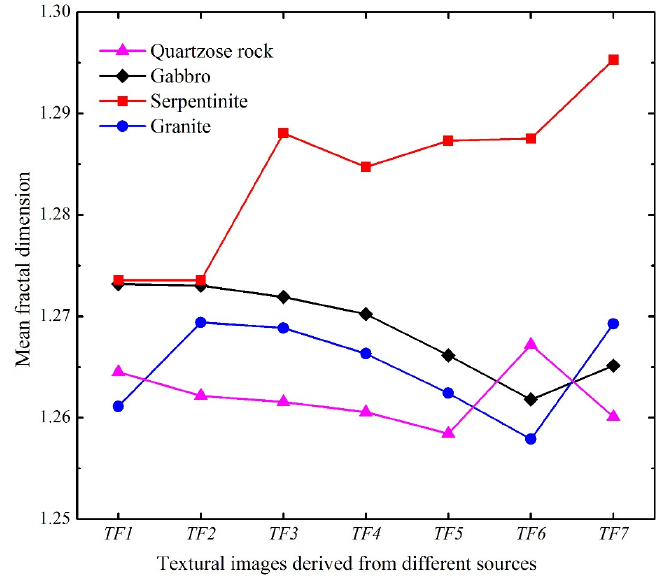
Figure 4. Mean fractal dimension ( FD ) value for the four rock types in seven texture images ( TFi represents textural feature image derived from spectral band i